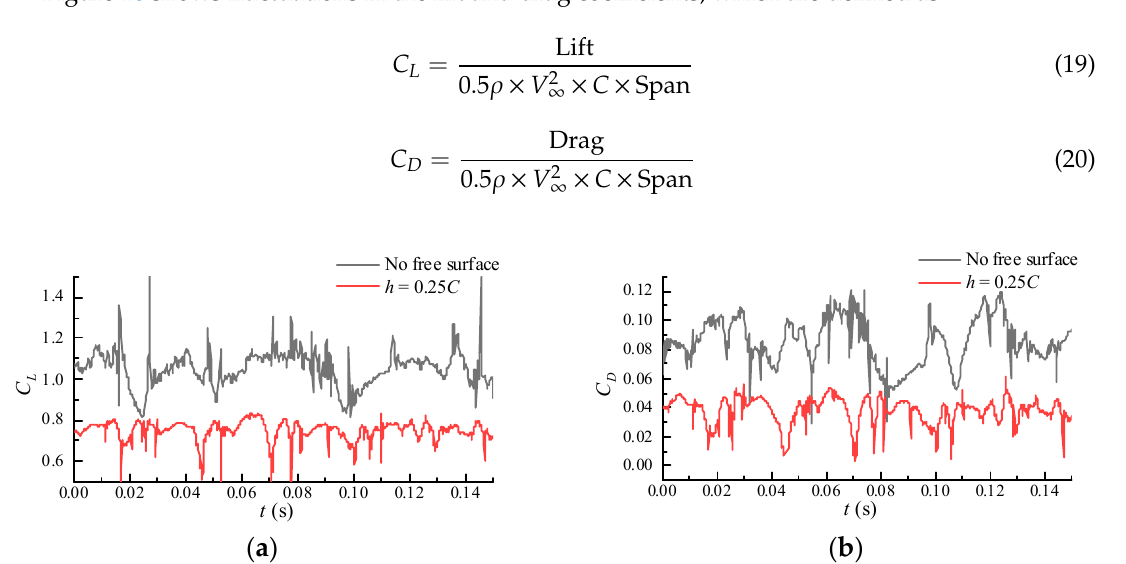
Figure 10. Comparison of the lift and drag coefficient fluctuations for the no free surface case and the near free surface case. ( a ) Lift coefficient; ( b ) Drag coefficient.